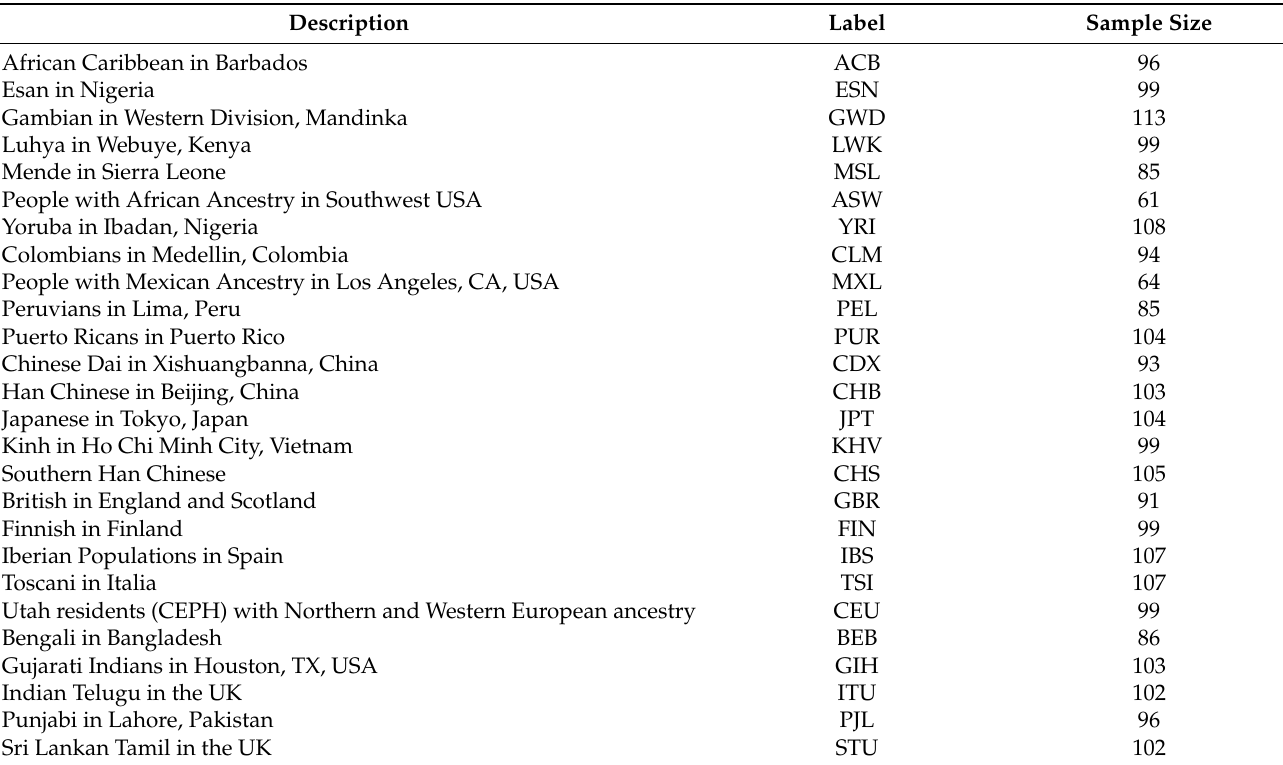
Table 1. 1000 Genomes Project Phase 3 data population